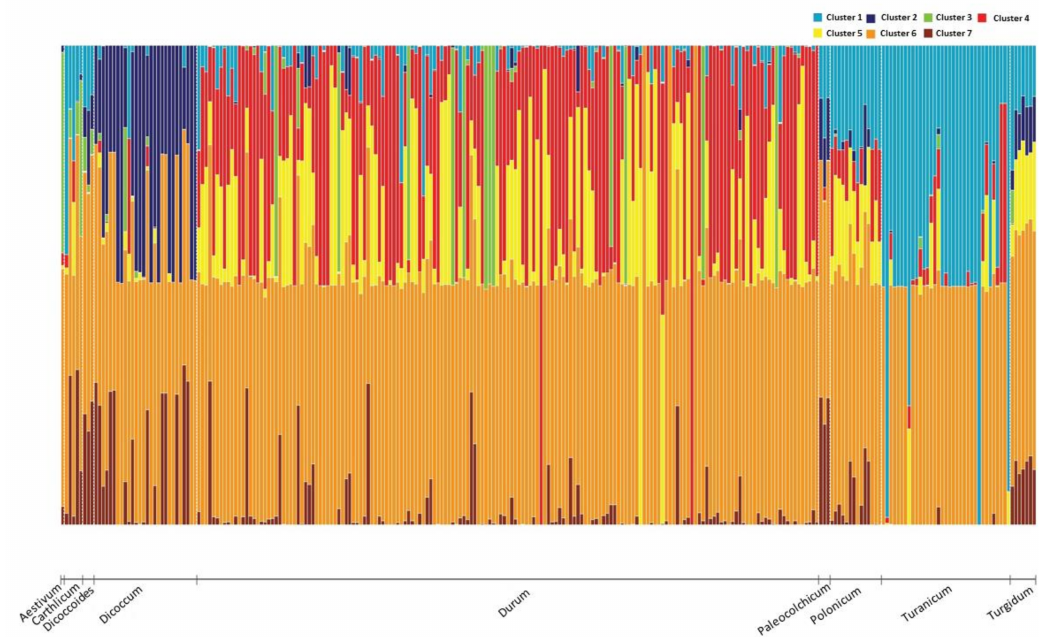
Figure 3. Diversity in admixture analysis by STRUCTURE among the 265 tetraploid wheat accessions. Each individual is represented by a horizontal line. Color codes follow the number of clusters, while the bar line under the graph represents the subspecies groups plus the outgroup genotypes ( T. aestivum